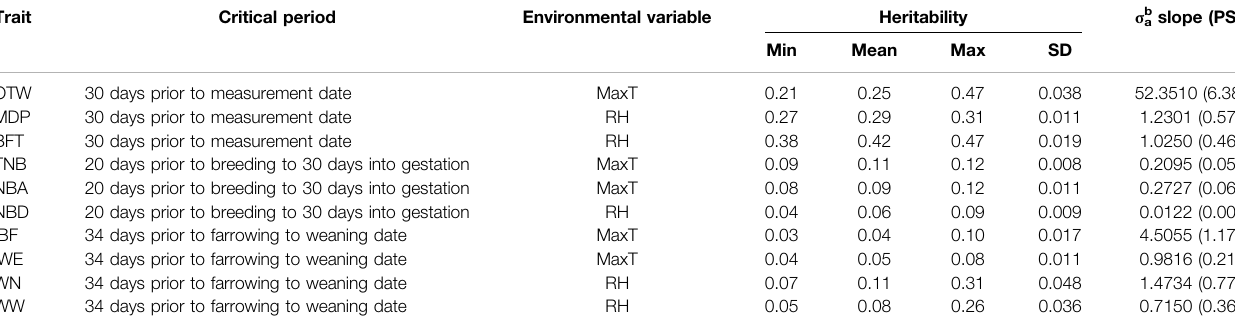
TABLE 3 | Description of heritability estimates of each selected environmental variable for each trait.